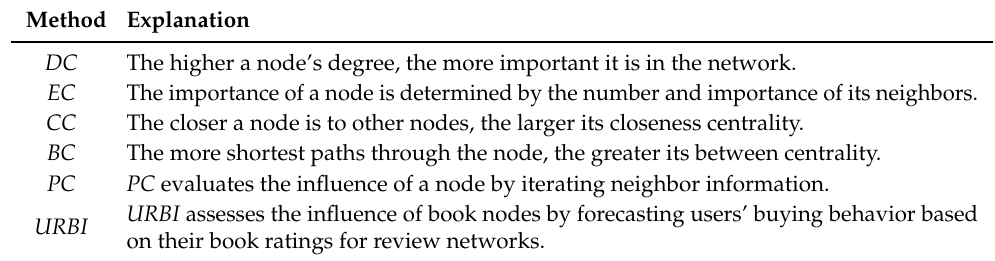
Table 1. Description of the six methods used in the